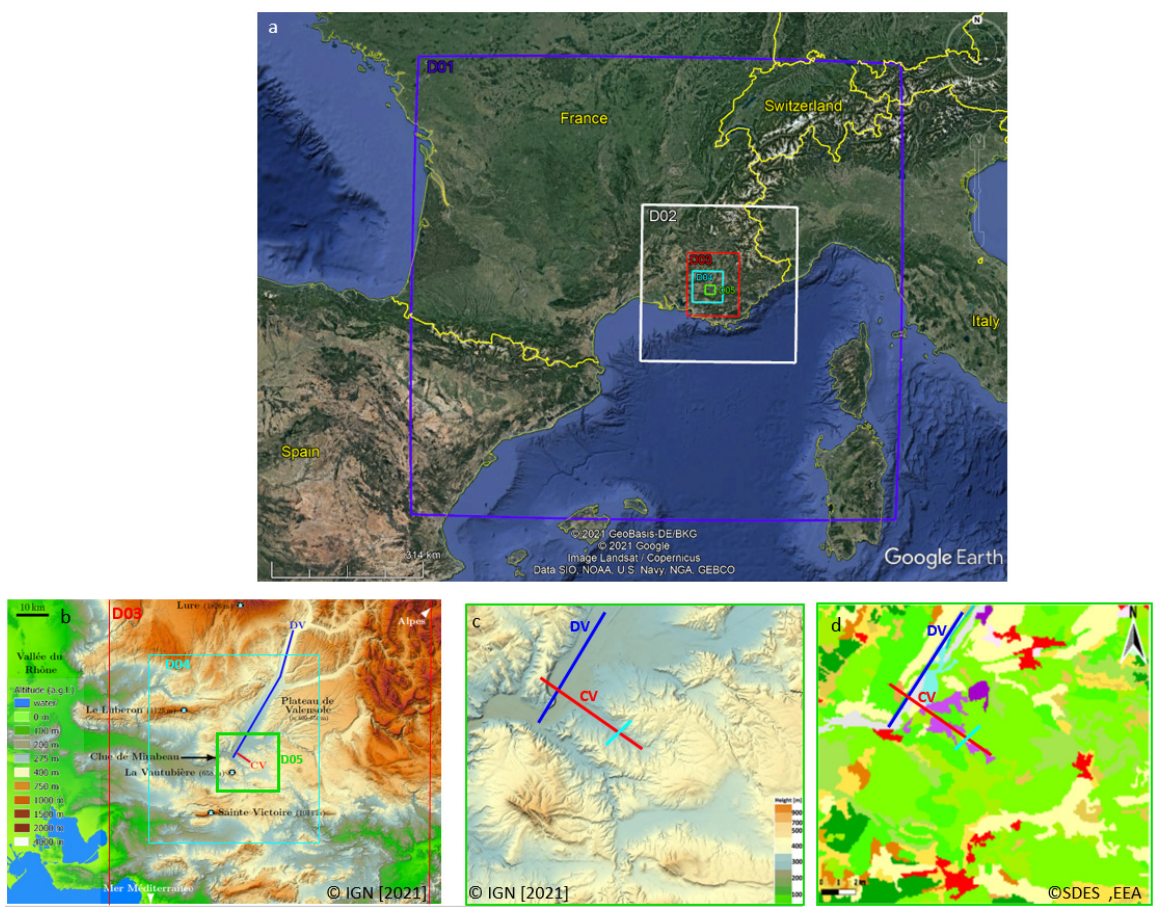
Figure 1. The locations of the different WRF nested domains used in this study ( a ), zooming in on the topography around the three inner domains ( b ) and the zoomed innermost domain with its topography ( c ) (steep slopes are shaded) and land cover ( d ) (see Appendix B for the color definition). CV, DV, and the corresponding red and blue lines in ( b ) represent the axes of the Cadarache and Durance valleys, respectively. The blue, red, and cyan lines in ( c , d ) mark the location of the cross-sections presented and discussed in Section 3.6.